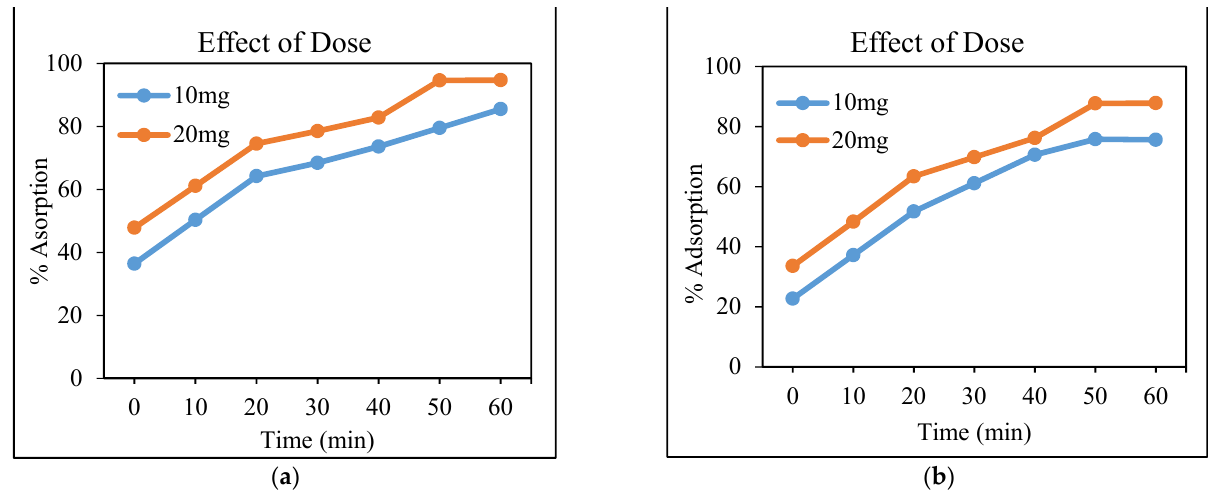
Figure 6. Removal (in percentage) of Cd ( a ) and Cr ( b ) using the CeO 2 /corncob nanocomposite as a function of adsorbent dose.